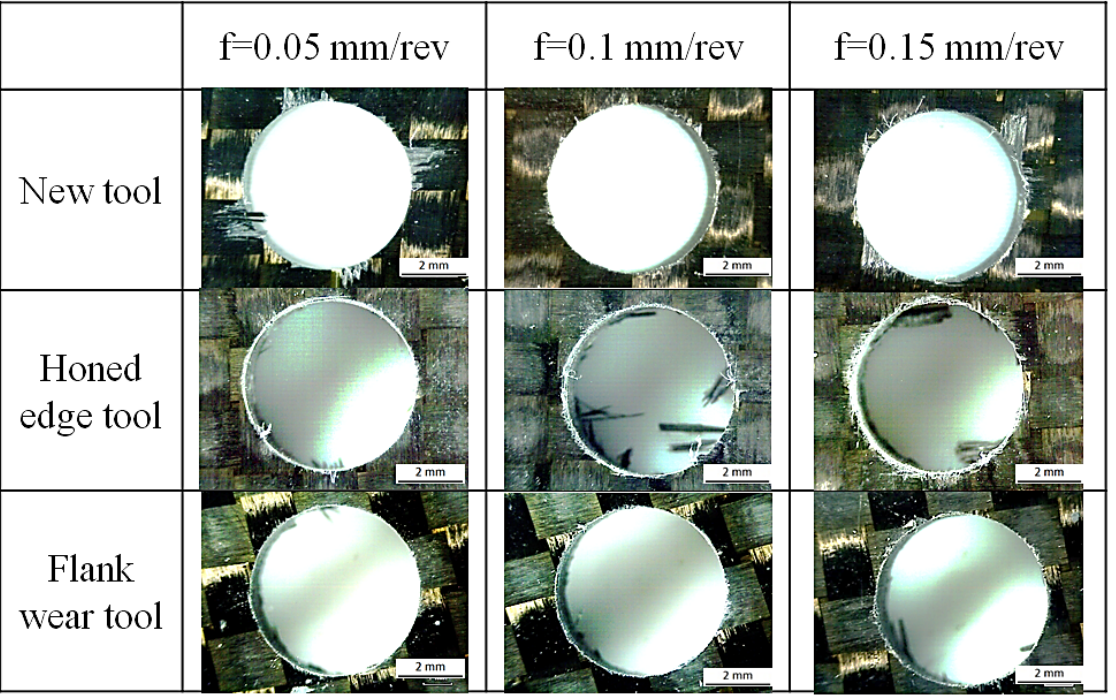
Figure 9. Hole entry quality variation with feed for different geometries with 180° point angle and V = 50